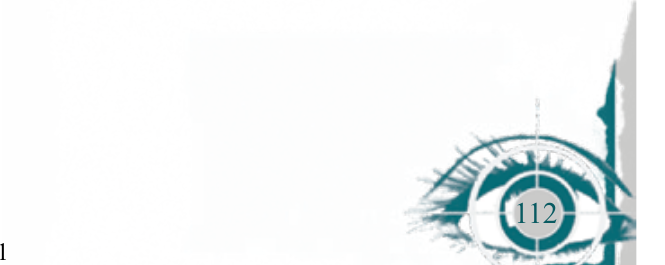
Figure 1: Bland-Altman plot of the difference between Tonopachy™ and GAT against the mean of Tonopachy™ and GAT in the 105 measurements in the study. The solid line in the Bland-Altman plot shows the mean difference (bias) and the small dashed lines represent 95% limits of agreement.